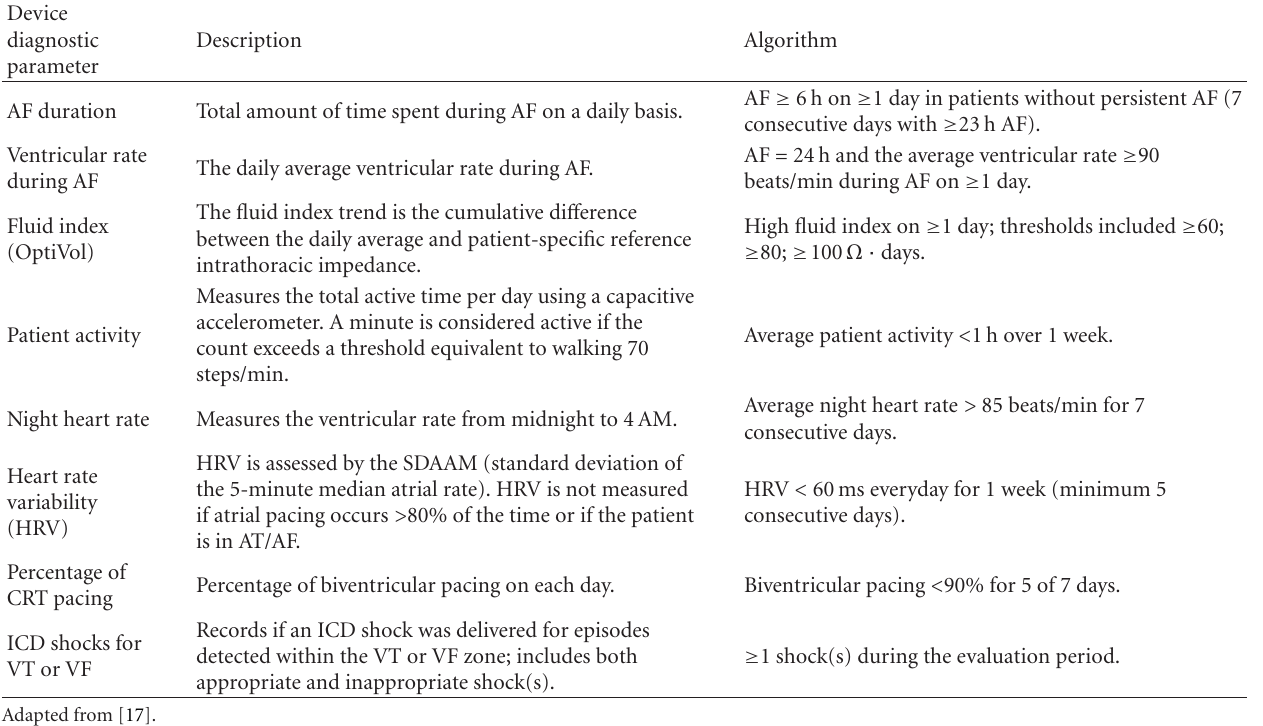
Table 1: Device diagnostics parameters and algorithms from the Cardiac Compass